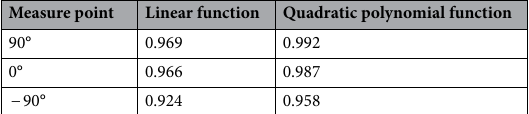
Table 3. Value of R 2